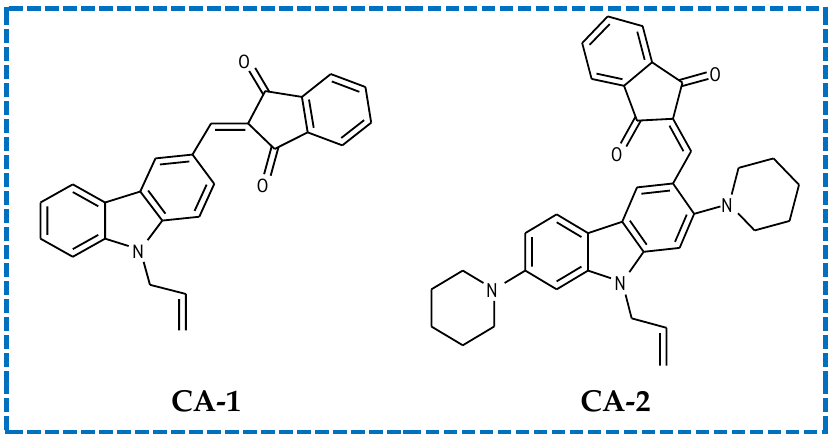
Figure 6. Chemical structures of carbazole-indanedione sensitizers proposed by Liao and colleagues [72]. The best results were obtained for PIS containing CA-2 dye. This sensitizer in com- bination with iodonium salt (diphenyliodonium hexafluorophosphate) provides highly efficient photoinitiation for hybrid polymerization of an acrylate/epoxyacrylate